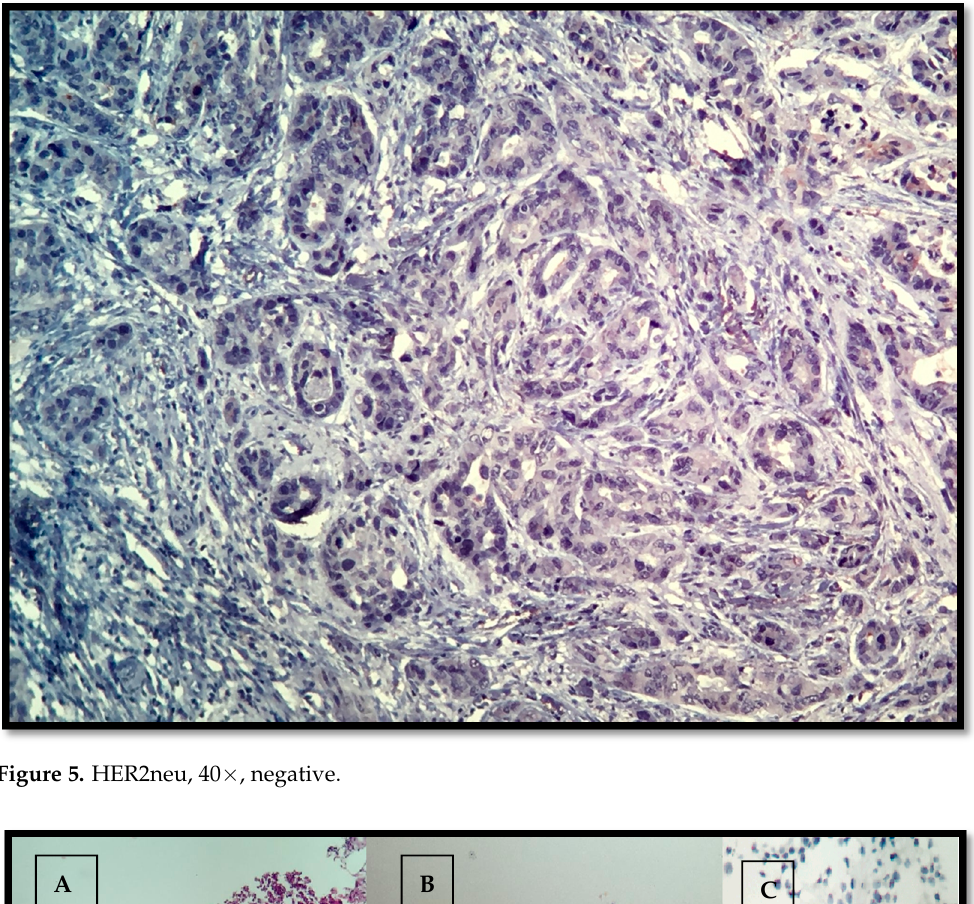
Figure 5. HER2neu, 40×, negative.